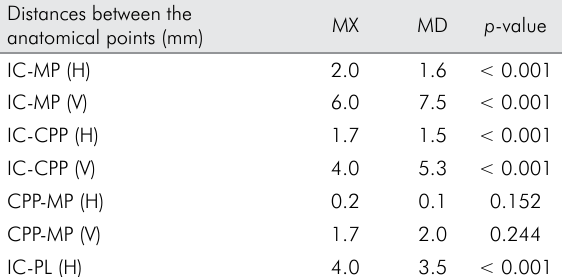
Table 1. Median distance values between the anatomical points in the vertical (V) and horizontal (H) directions related to groups of maxillary molars (MX) and mandibular molars (MD).